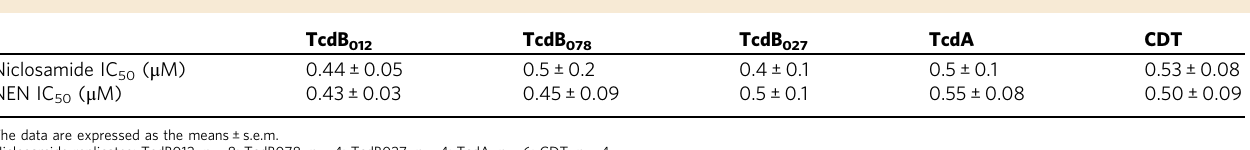
Table 1 Inhibition of C. dif fi cile toxin-induced cytotoxicity by niclosamide and NEN